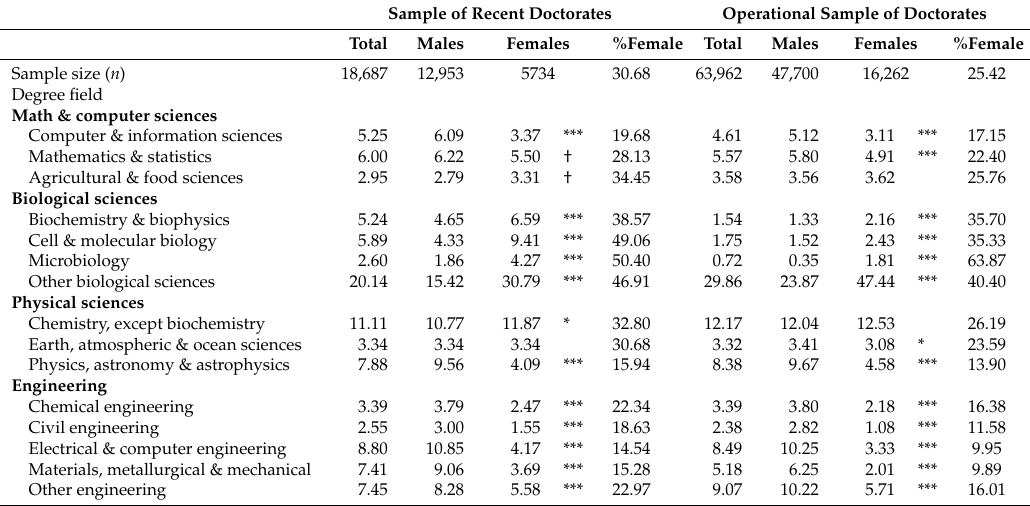
Table A1. Percent distribution of analytical and operational samples by degree field and